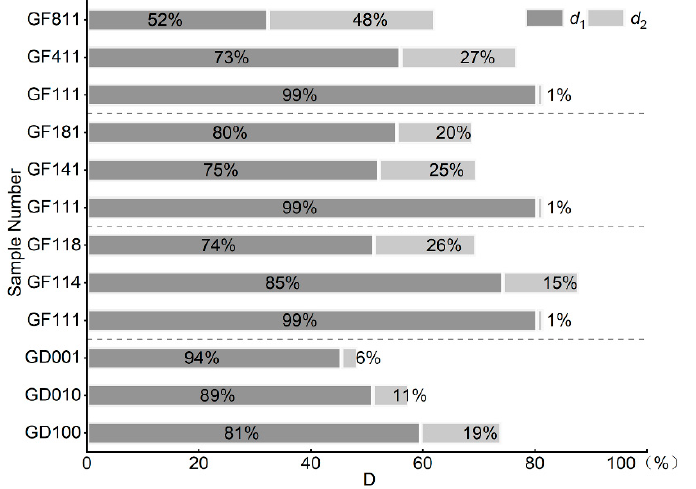
Figure 8. The bar of relative resistivity change.